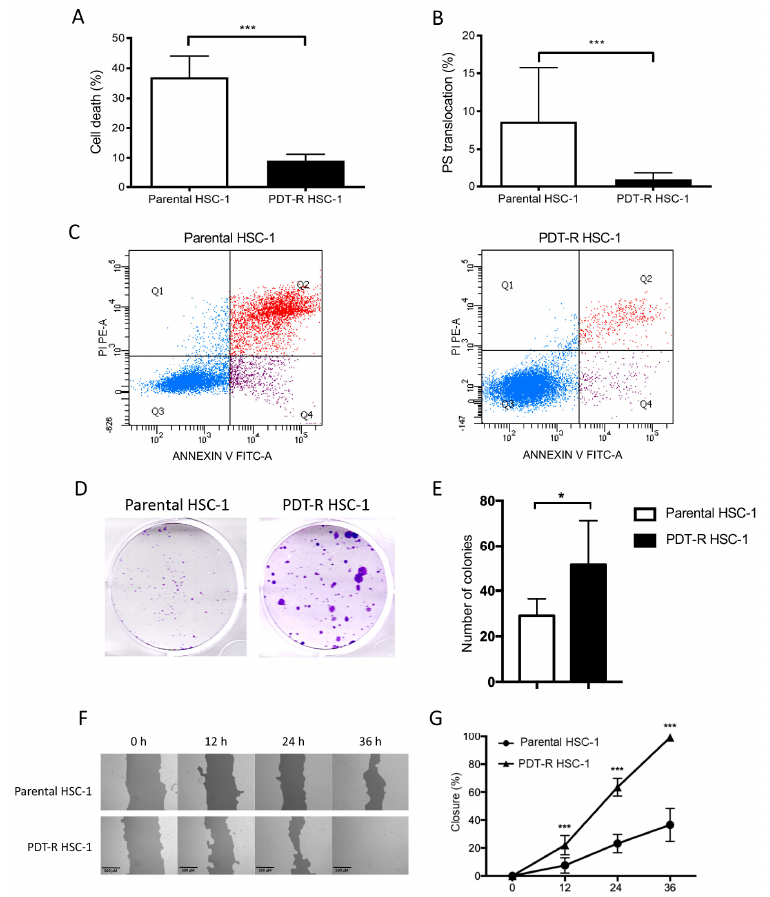
Figure 2. Cell death and proliferation capacity analysis. ( A ) Cell death analysis (AV (+) and PI (+)); ( B ) PS translocation (AV (+)). ( C ) Representative plot of the flow cytometry for cell death and PS translocation assays in parent and resistant cells. ( D ) Clonogenic assay, 500 cells were seeded in each plate for 14 days. ( E ) Quantification of colonies formed in parental HSC-1 and resistant cells. ( F ) Representative images of wound closure in parental HSC-1 and resistant cells. ( G ) Percentage of wound closure in resistant cells compared to parental HSC-1. Values of p < 0.05 were considered statistically significant. * p < 0.05; *** p < 0.001. Data were expressed as mean ± SD of three biological replicates. 2.3. PDT-Resistant HSC-1 Cells Show Lower Levels of PpIX and ROS than Parental Cells To determine the cellular location and intracellular content of PpIX, parental and resistant HSC- 1 cells were observed by fluorescence microscopy after incubation with 2 mM of MAL. PpIX was located in the cytoplasm of both parental and resistant HSC-1 cells (Figure 3A). However, parental cells showed 80% positive cells for PpIX at 4 h post-incubation with MAL, while resistant cells